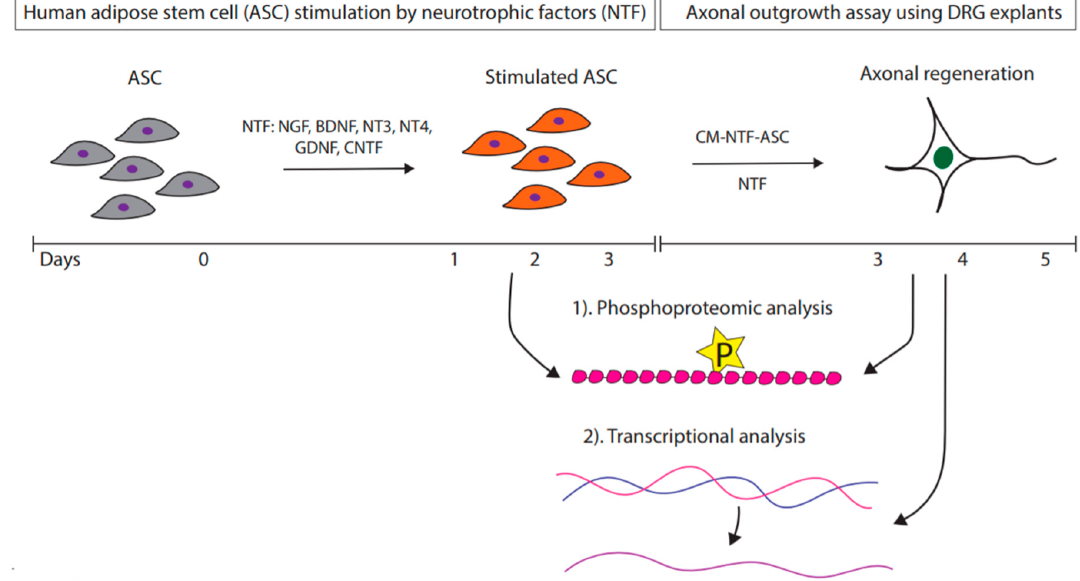
Figure 1. Ex-vivo stimulation of adipose stem cells using di ff erent neurotrophic factors. Key. NTF: neurotrophic factors; NGF: nerve growth factor; BDNF: brain-derived neurotrophic factor; NT3: neurotrophin 3; NT4: neurotrophin 4; GDNF: glial cell-derived neurotrophic factor; CM-NT3-ASC: conditioned medium derived from adipose stem cells; DRG: dorsal root ganglion.